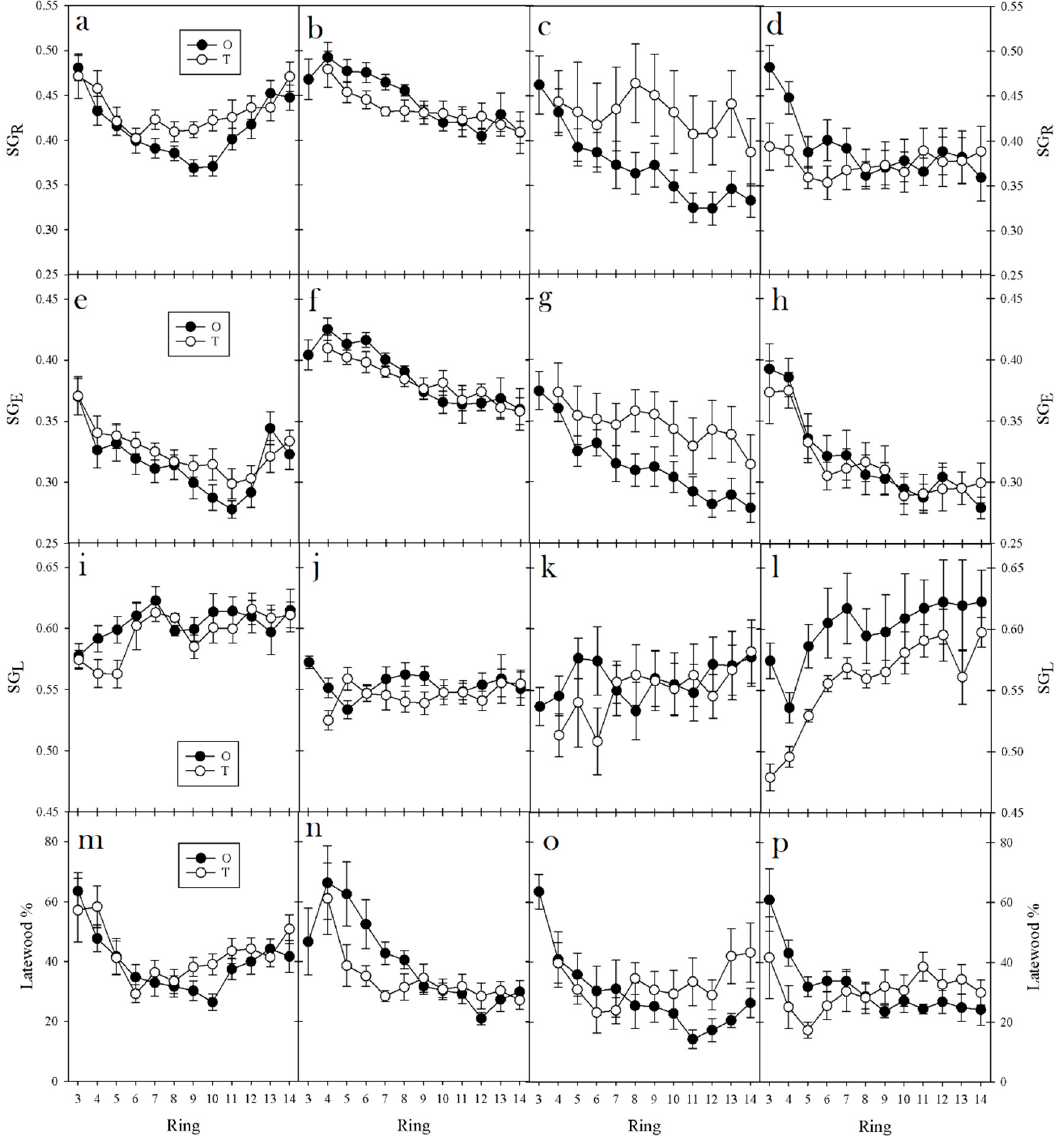
Figure 3. Ring specific gravity (SG R ; a – d ); earlywood specific gravity (SG E ; e – h ); latewood specific gravity (SG L ; i – l ); and latewood percentage ( m – p ) for: Douglas-fir ( a , e , i , m ); western hemlock ( b , f , j , n ); western redcedar ( c , g , k , o ); and grand fir ( d , h , l , p ) trees growing under contrasting vegetation management treatments on a site located in the Coastal Range of western Oregon. O: no post-planting vegetation control (open symbol); T: sustained vegetation control during first five years post planting (filled symbol). Error bars represent standard error.